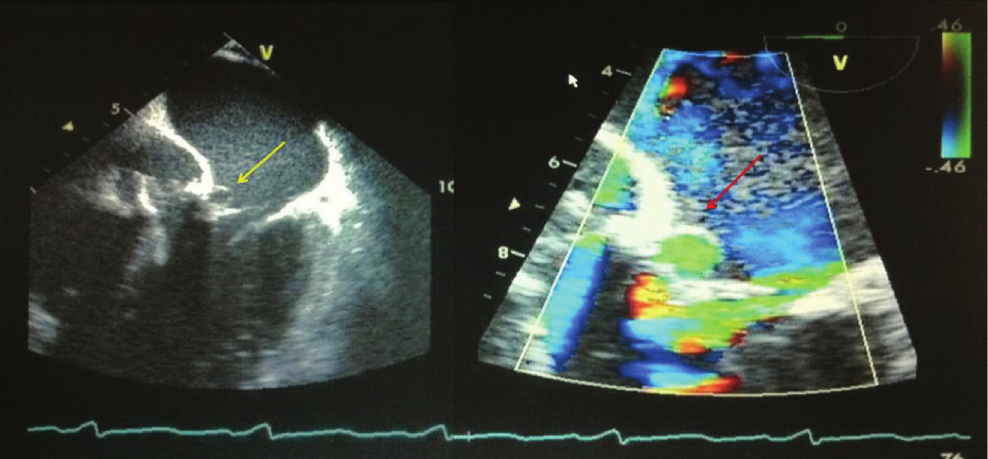
Figure 3: TEE depicting systolic ballooning of the aneurysmal segment of the P-MAIF (yellow arrow) and Doppler evidence of flow within the P-MAIF (red arrow).